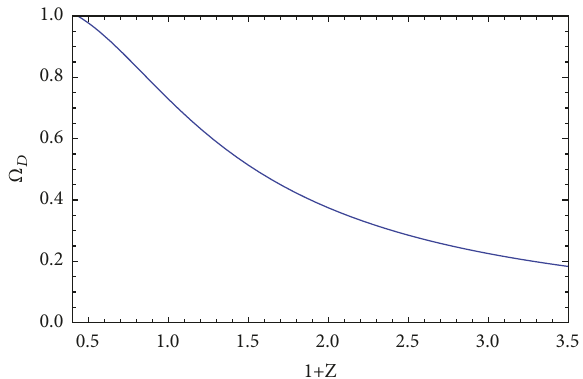
Figure 1: The evolution of Ω 𝐷 versus redshift parameter 𝑧 for noninteracting GDE in DGP model. Here, we have taken Ω 𝐷 (𝑧 = 0) = 0.73 , 𝐻(𝑧 = 0) = 67 , and Ω = 0.0003 . 𝑟 𝑐